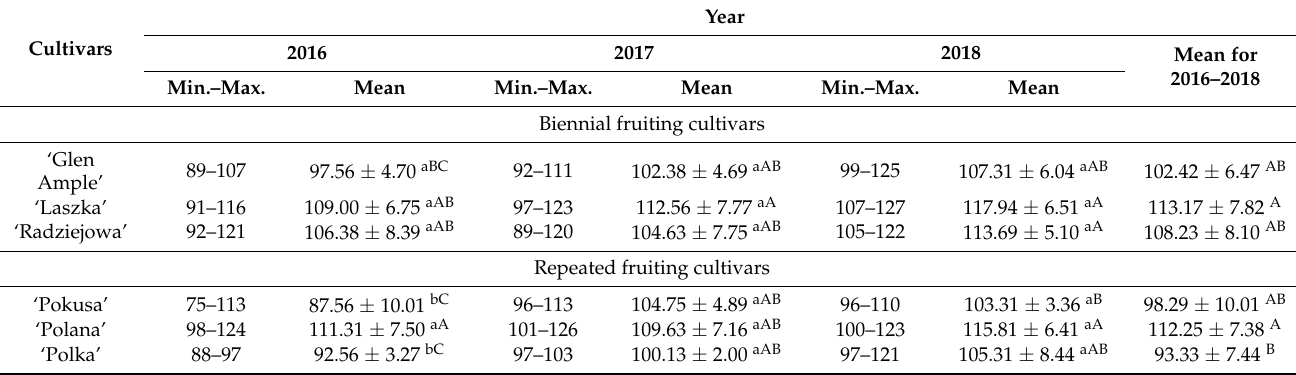
Table 1. Number of stamens per flower in six R. idaeus cultivars.